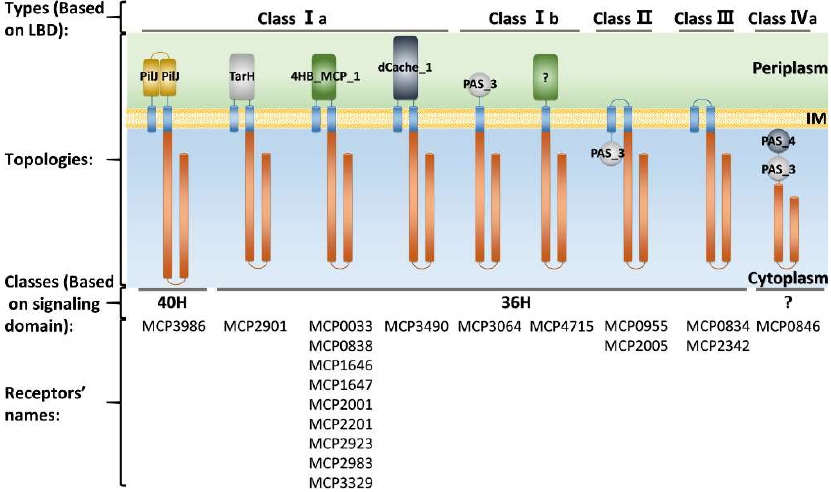
Figure 2. The chemoreceptor repertoires of C. testosteroni CNB-1 and their classification. Domain architecture of chemoreceptors was identified by using CDvist [49].